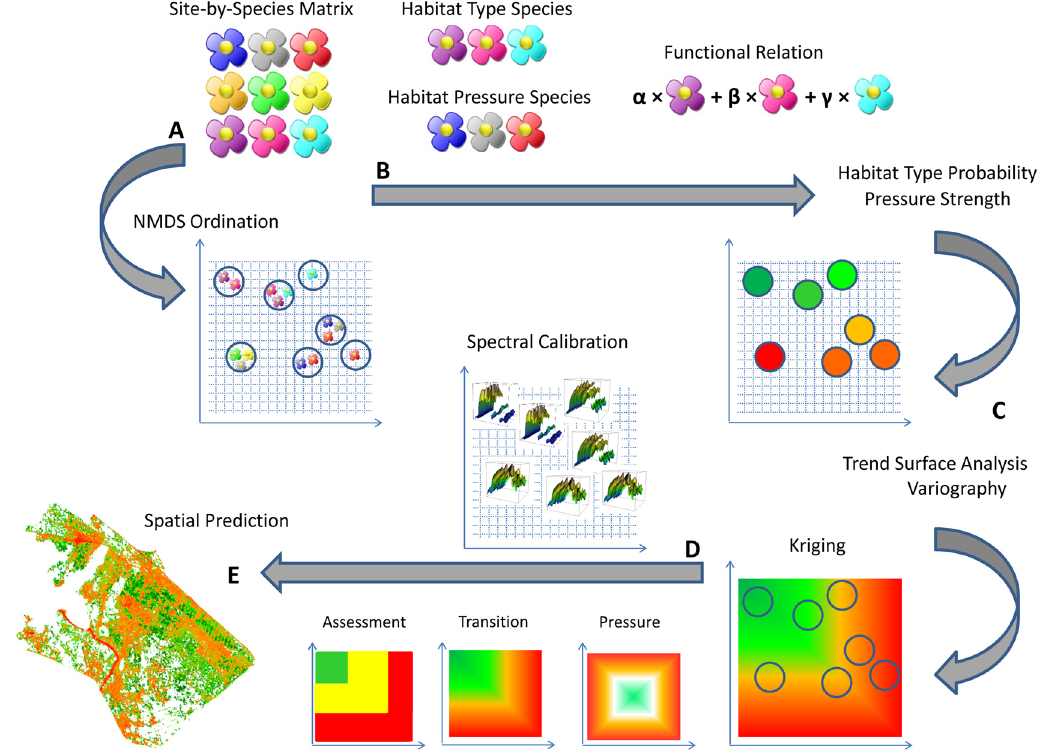
Figure 2. Methodological framework presented as a conceptual workflow: ( A ) plant species ordination; ( B ) functional habitat type and pressure aggregation; ( C ) continuous pattern prediction; ( D ) pattern recognition and spectral calibration; and ( E ) spatially explicit predictions on the basis of image